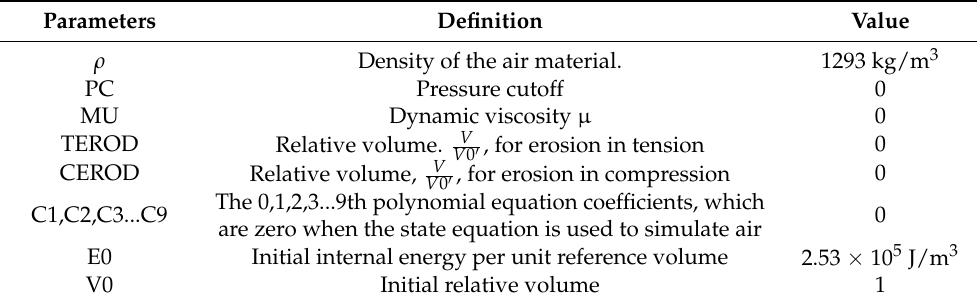
Table 2. Parameters of the air material model and the equation of state.